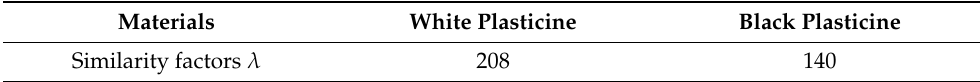
Table 8. Similarity factors of the flow curves λ for the model